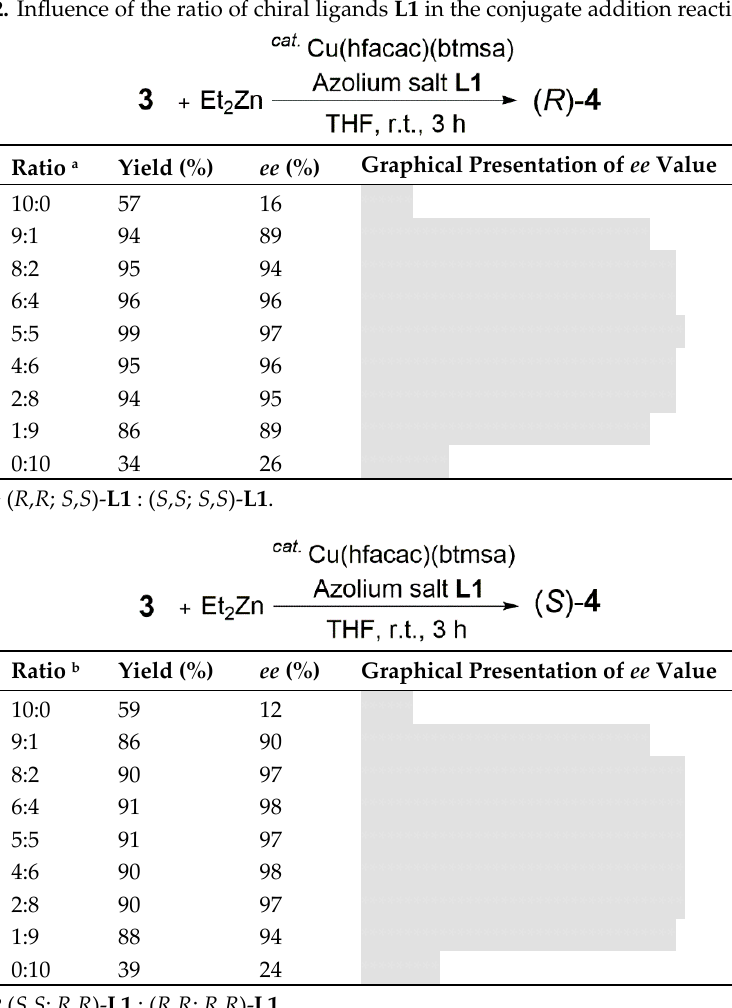
Table 2. Influence of the ratio of chiral ligands L1 in the conjugate addition reaction of 3.